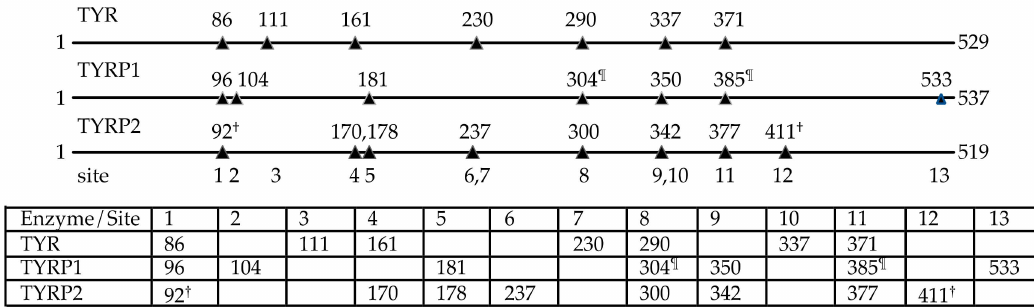
Figure 4. N -glycosylation sites in mammalian melanogenic enzymes. Indicated are the sequence positions of Asn residues that are part of N-X-S / T N -glycosylation sequence motifs in human, mouse, rabbit, and rat TYR, TYRP1, and TYRP2. Thirteen di ff erent putative N -glycosylation sites are present. The residue numbering is according to the sequence numbering of human TYR, human TYRP1, and human TYRP2, respectively. The sequences of human, mouse, rabbit, and rat TYR, TYRP1, and TYRP2 were retrieved from the UniProtKB protein knowledgebase (www.uniprot.org), with entry numbers P14679 (human TYR), P11344 (mouse TYR), G1SYA0 (rabbit TYR), D4A9G4 (rat TYR), P17643 (human TYRP1), P07147 (mouse TYRP1), G1SLB6 (rabbit TYRP1), D3ZH71 (rat TYRP1), P40126 (human TYRP2), P29812 (mouse TYRP2), and G1TFA4 (rabbit TYRP2). † Asn92 is not present in human TYRP2; Asn411 is only present in mouse TYRP2. ¶ Asn304 is not present in mouse and rat TYRP1; Asn385 is not present in rabbit